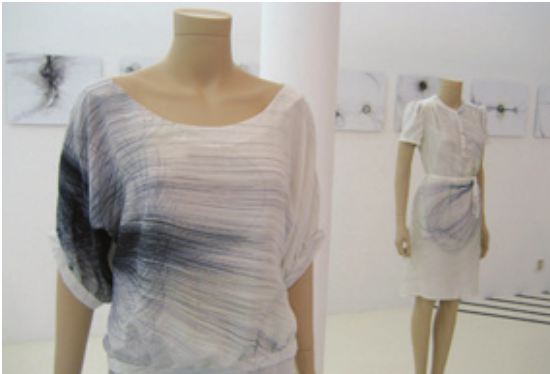
Figure 4 : Reas’s Tissue Collection Fig. 4. Reas’s Tissue Collection (cid:1)